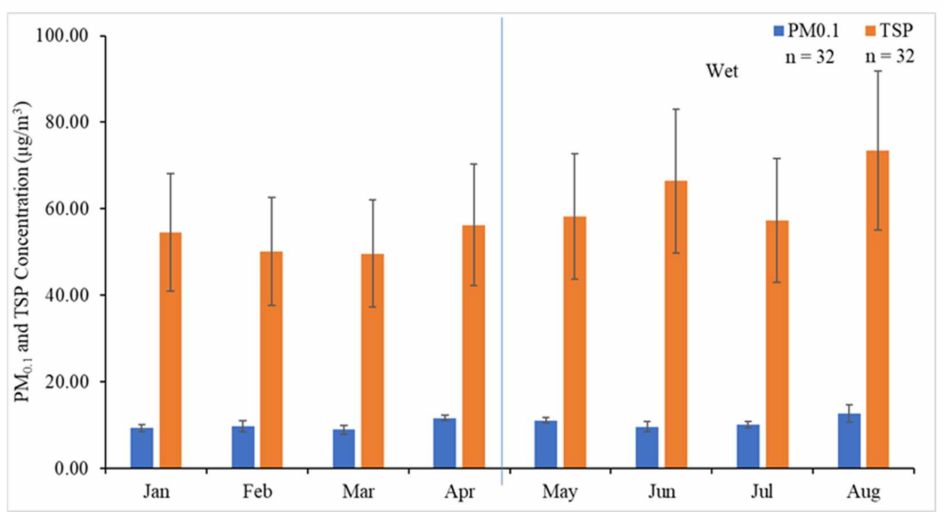
Figure 2. Average mass concentrations of PM 0.1 and TSP in Hat Yai, Songkhla, Thailand during dry and wet seasons,